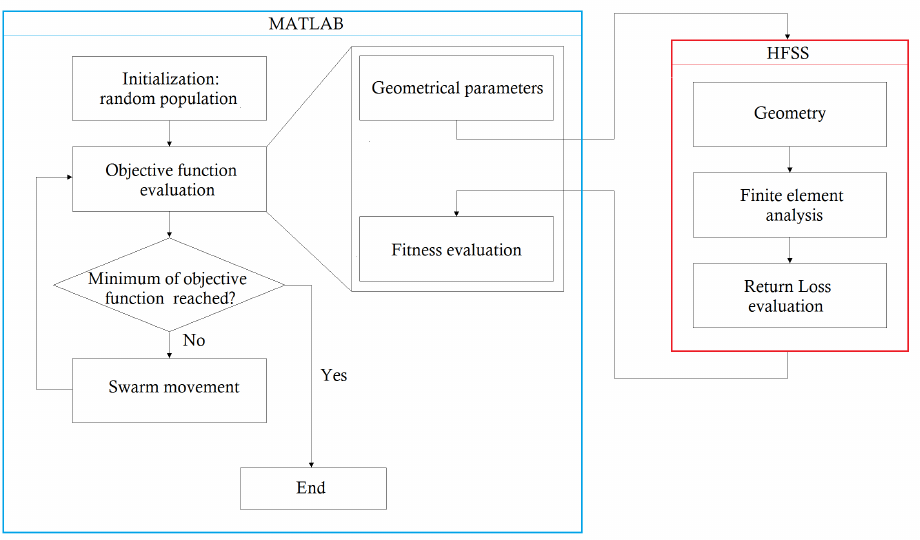
Figure 6. Optimization scheme: PSO and HFSS